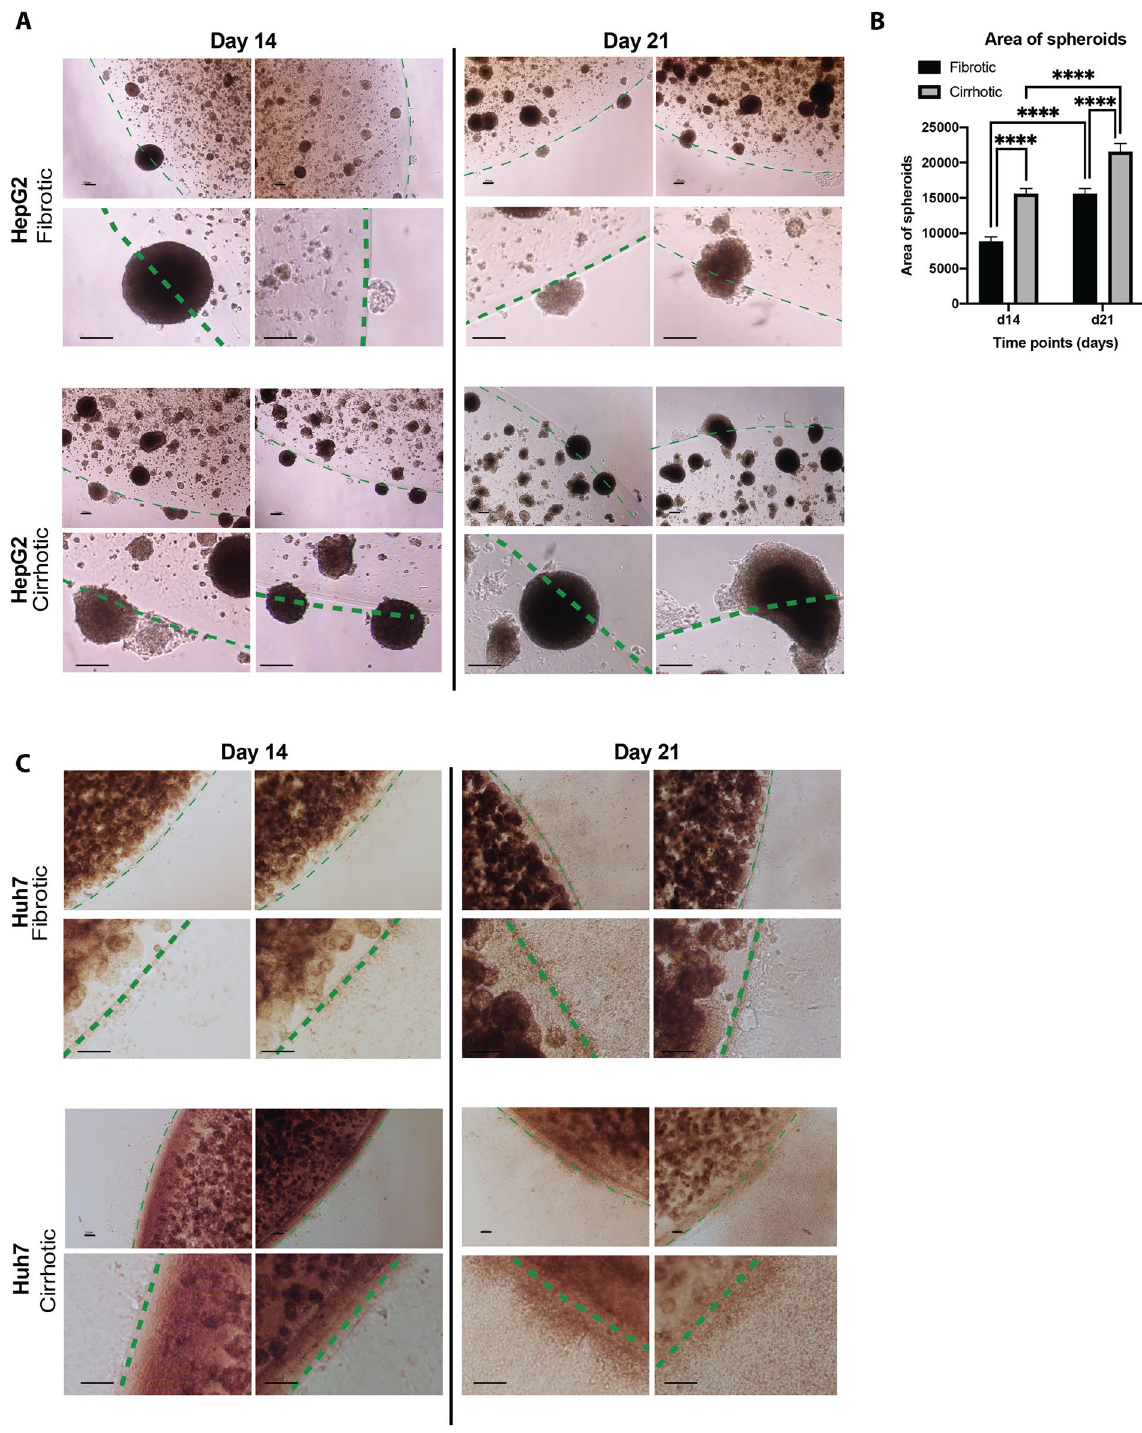
Figure 3. ( A ) Photomicrographs of tumour HepG2 spheroids forming in a 3D fibrotic and cirrhotic hydrogel after 14 and 21 days in culture. ( B ) Surface area of tumour nodules formed on day 14 and 21 in both fibrotic and cirrhotic environments. ( C ) Photomicrographs of Huh7 cells outside the hydrogel after 14 and 21 days in culture (dashed green line marks edge of gels, n = 150, error bars = SD, **p < 0.001, Scale bar = 100